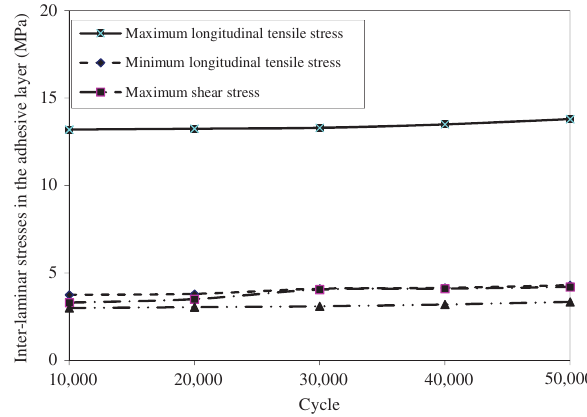
Figure 14: Variations in the shear and longitudinal tensile stresses in the adhesive layer at mid-span (FEM approach).